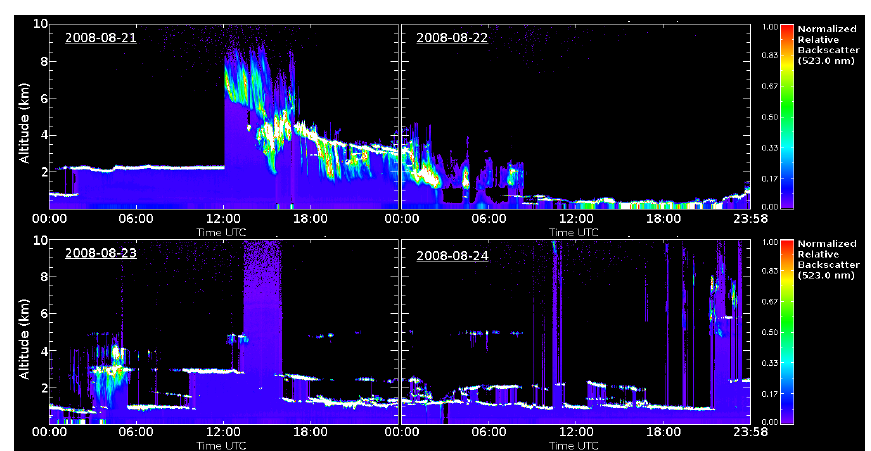
Figure 5. Normalized relative backscatter (Level 1.0 data) based on lidar measurements at Ny-Ålesund recorded during the period 21– 24 August 2008 (modified from http://mplnet.gsfc.nasa.gov/).